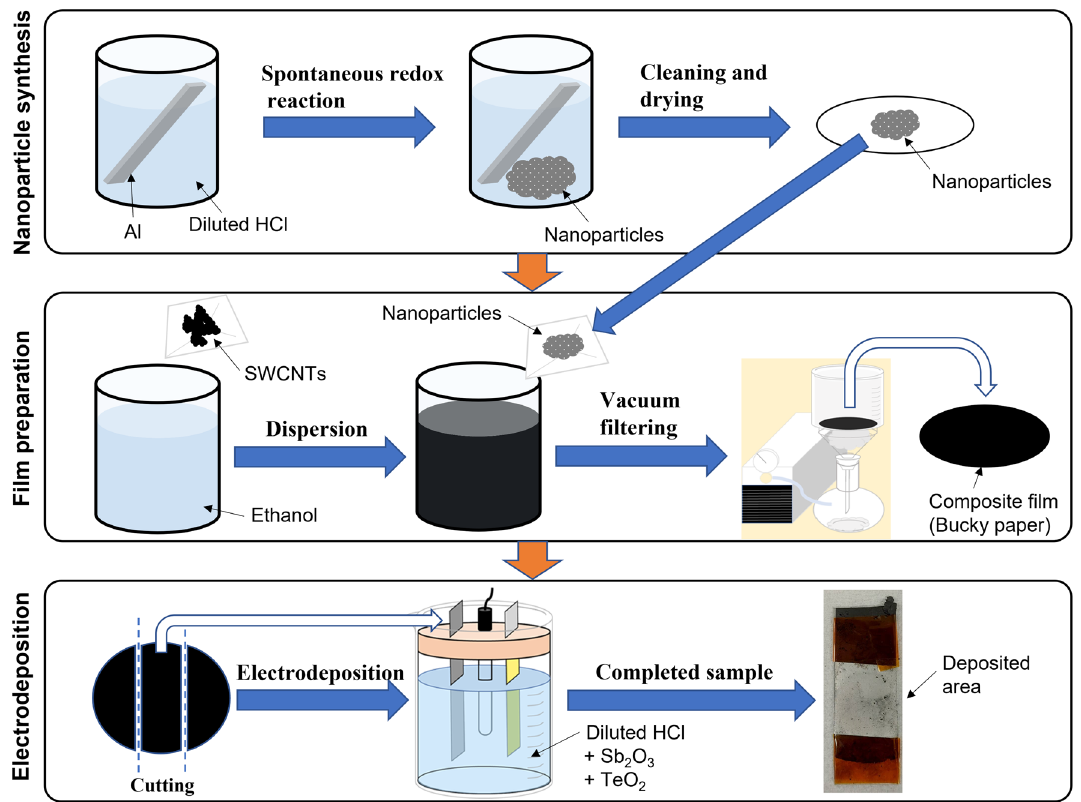
Figure 1. Schematic diagram of the fabrication processes: nanoparticle synthesis, nanocomposite film preparation, and